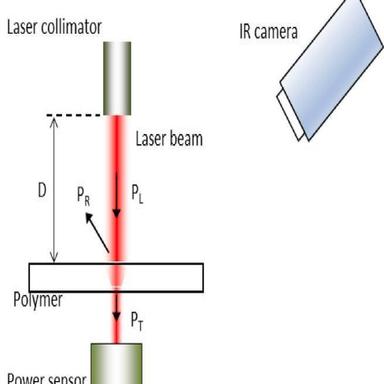
Laser treatment scheme of the sample (PL, PR and PT indicate the Laser Power, the Reflected and the Transmitted Power respectively).